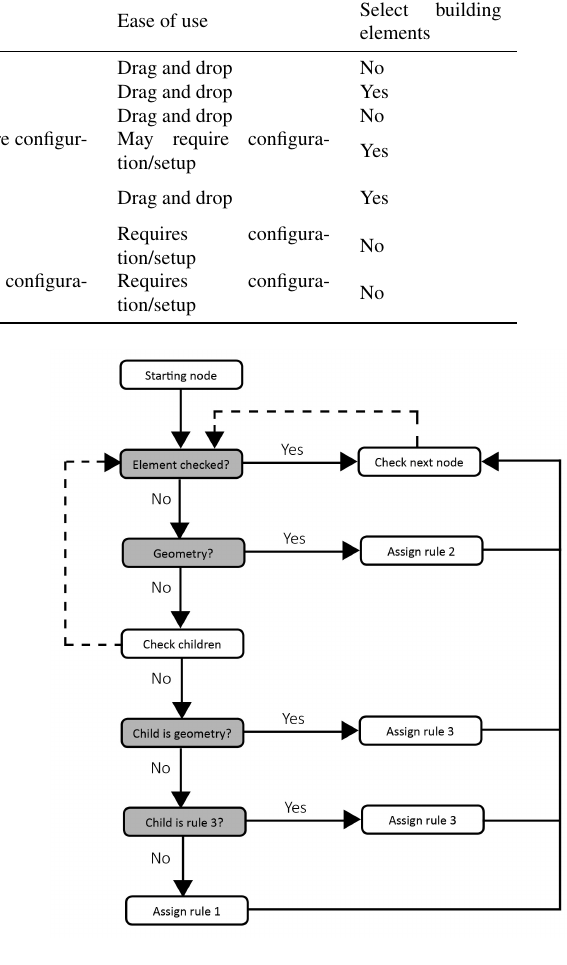
Figure 2. Illustration of the developed